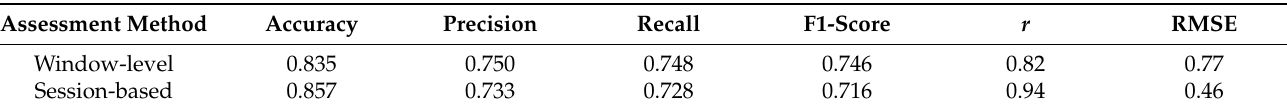
Table 4. Results of different assessment methods for bradykinesia detection using the proposed CNN with patch input and Random Forest classification. RMSE: root mean square